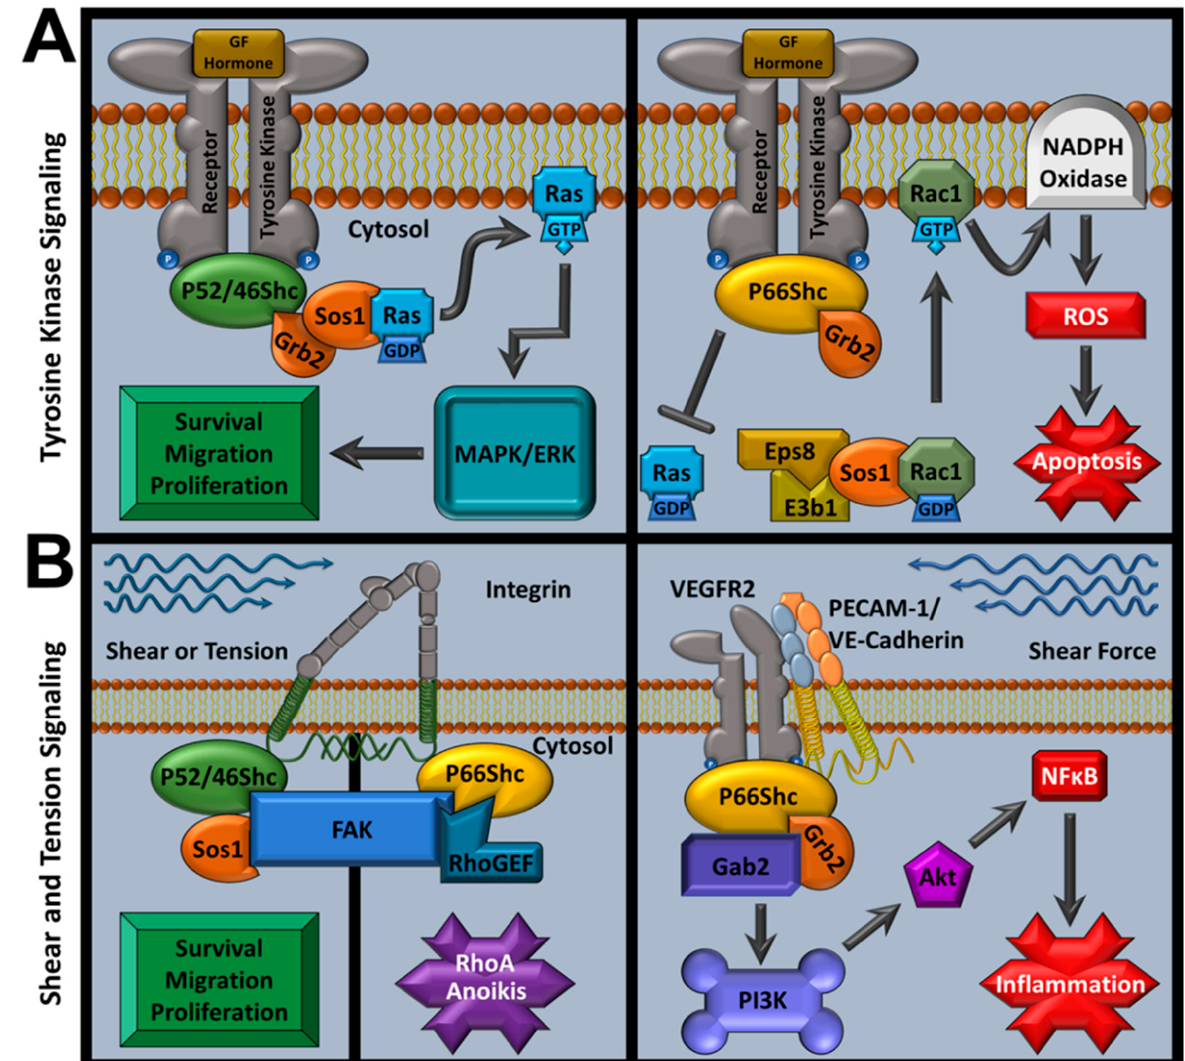
Figure 2. ShcA signaling summary. ( A ) ShcA responses to tyrosine kinase growth factor (GF) and hormone signals. P52/46Shc causes Ras-dependent MAPK/ERK signaling that promotes survival, migration, and proliferation; left panel. p66Shc inhibits Ras signaling by competitively increasing Rac1-mediated ROS generation via NADPH oxidase activation; right panel. ( B ) ShcA-mediated integrin and VEGFR2-Cadherin-PECAM responses to shear force or tension signals. Integrin shear or tension signals result in p52/46Shc pro-survival signaling via FAK-Sos1 while p66Shc leads to anoikis via RhoGEF-RhoA signaling; left panel. Endothelial VEGFR2-VE-Cadherin-PECAM-1 complexes respond to shear by increasing p66Shc-mediated inflammation via Gab2-PI3K signaling; right panel.